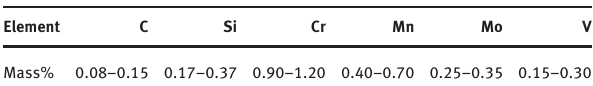
Table 1: The chemical compositions of the 12Cr1MoV alloy. Element